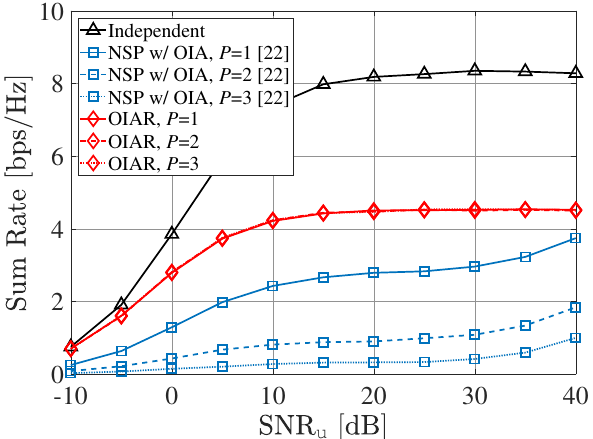
Figure 6. Sum-rate of communication system according to SNR u with different P .